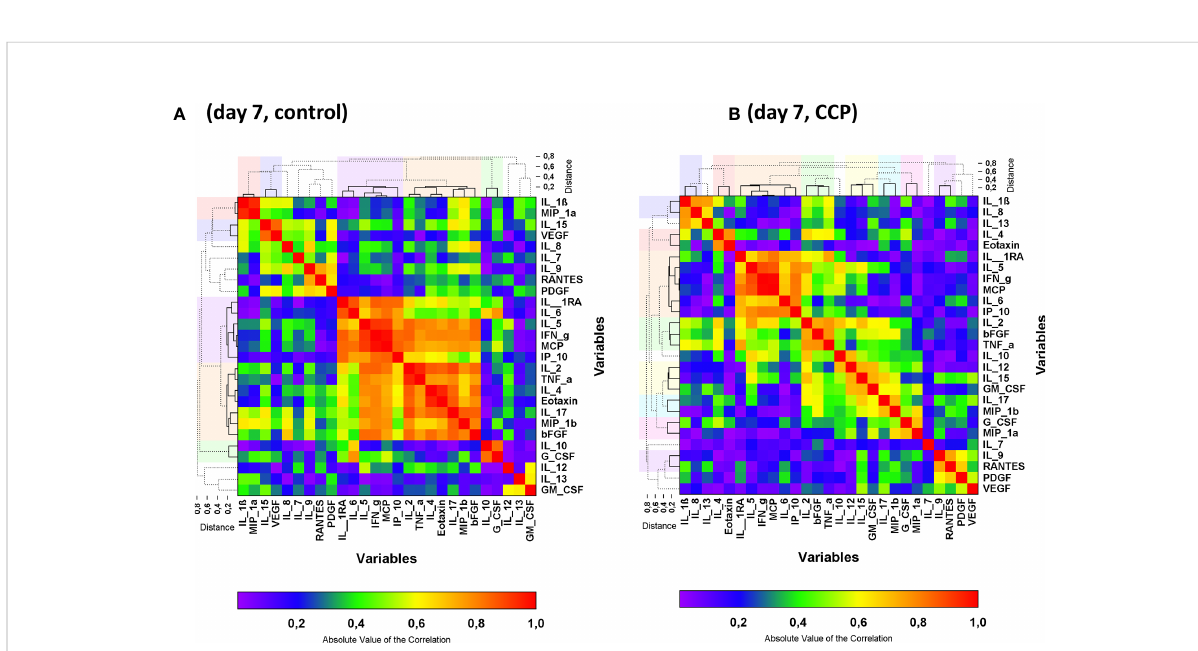
FIGURE 3 Heat map of the absolute values of the correlation matrix on day 7 strati fi ed by randomization group: control (A) and CCP (B) . Clustered cytokines are indicated by the solid lines in the dendrograms and the clusters are indicated by the colors above and beside the graph. Non- clustered cytokines are shown by the dashed lines in the dendrogram. Clusters were formed by the unweighted group method. Cluster reports for the absolute values of the correlation matrix are presented in Table